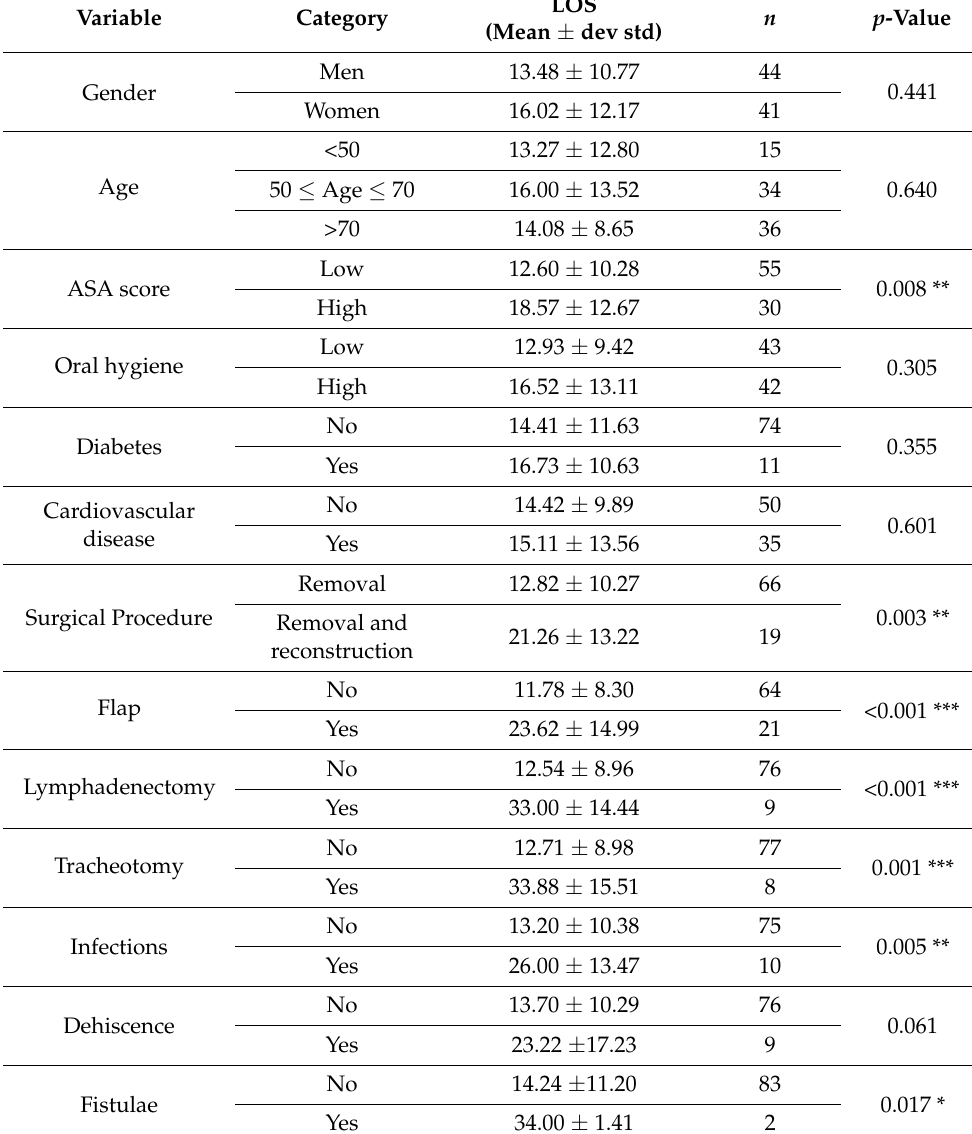
Table 2. Variables influencing LOS for Ceftriaxone have been studied by comparing all the categories related to each variable by applying Mann–Whitney U/Kruskal–Wallis tests. * Significance at 0.05; ** significance at 0.01; *** significance at